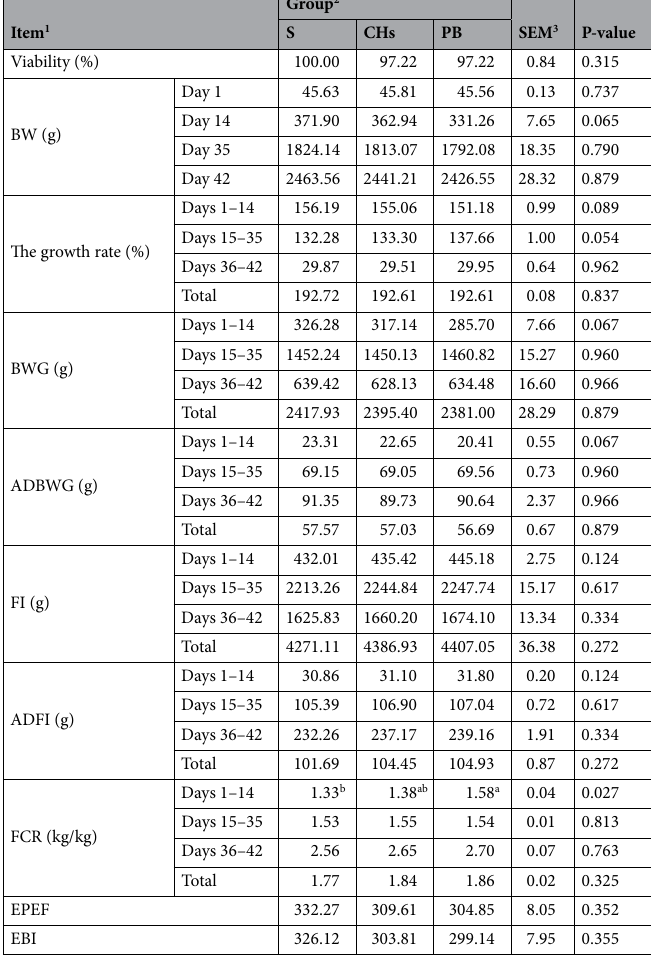
Table 2. Growth performance of broiler chickens. a,b Different letters in the row indicate statistically significant differences between the groups, P-value < 0.05; letters are given from the highest (a) to the lowest value (…) ; 1 , BW, body weight; BWG, body weight gain; ADBWG, average daily body weight gain; FI, feed intake; ADFI, average daily feed intake; FCR, feed conversion ratio; EPEF, European Production Efficiency Factor; EBI, European Broiler Index; 2 , S, chopped wheat straw bedding; CHs, crude coffee husks bedding; PB, pelleted bedding with 50% of chopped wheat straw and 50% of coffee husks; 3 , SEM, standard error of the